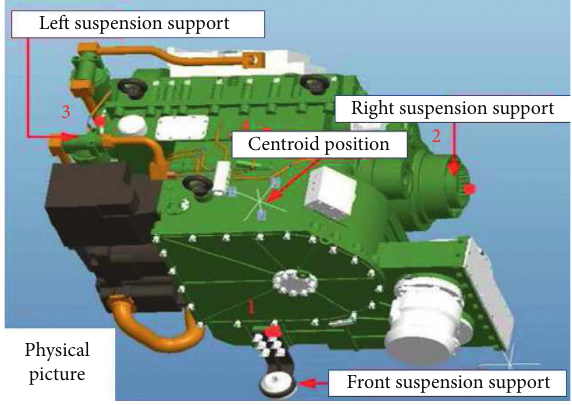
Figure 9: Fixed housing joint.